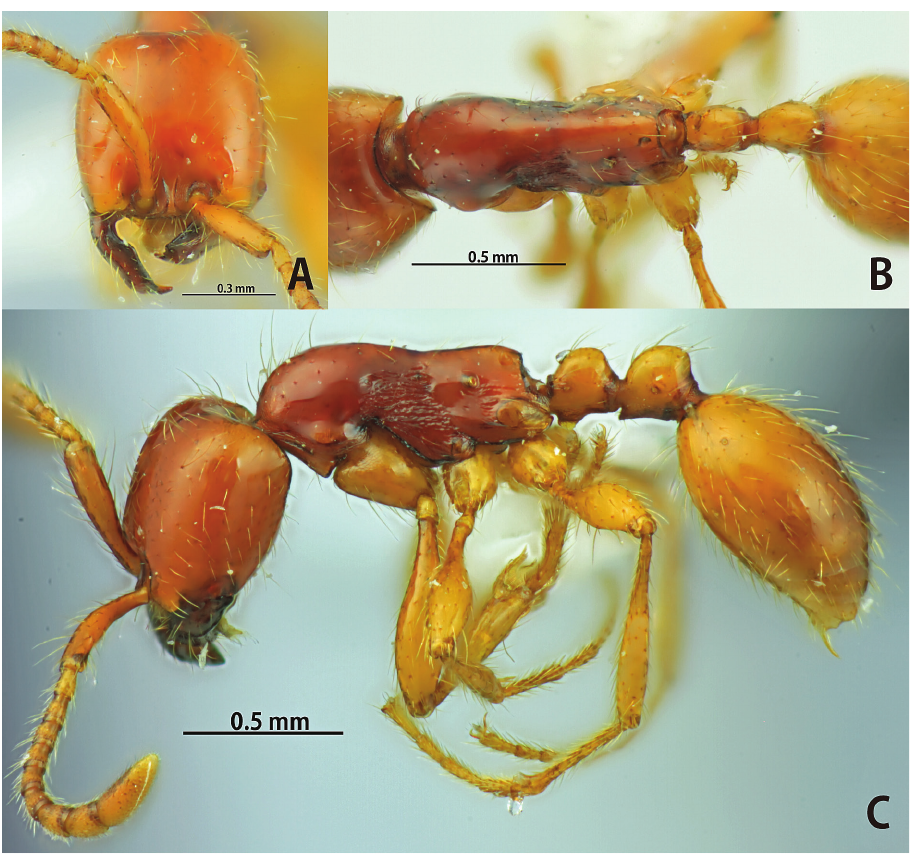
Figure 14. Aenictus minipetiolus (holotype). A Head in full-face view B body in dorsal view C body in